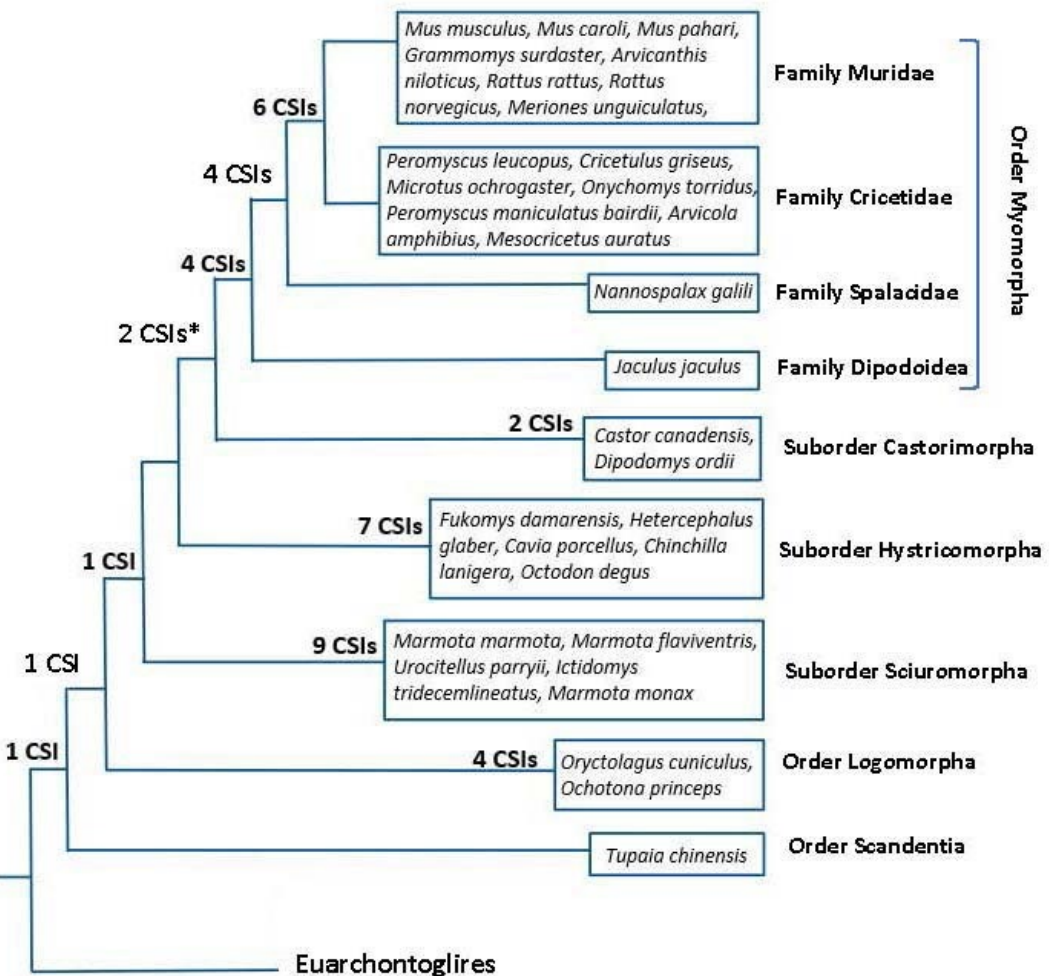
Figure 8. A conceptual diagram summarizing the overall evolutionary relationships among the Rodent/Glires species Rodent/Glires species based on their branching in a phylogenetic tree constructed from sequences of based on their branching in a phylogenetic tree constructed from sequences of 25 conserved proteins, and the clade spec- 25 conserved proteins, and the clade specificities of the CSIs identified in this work. The numbers of ificities of the CSIs identified in this work. The numbers of CSIs, which are specific for different clades are indicated on CSIs, which are specific for different clades are indicated on the nodes. The asterisk (*) indicates that the nodes. The asterisk (*) indicates that one of these CSIs was lacking in the species Jaculus jaculus . one of these CSIs was lacking in the species Jaculus jaculus